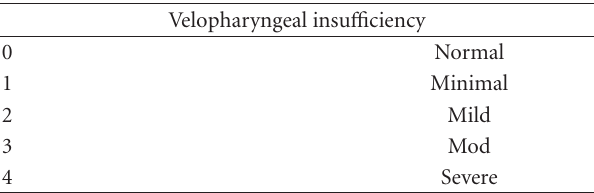
Table 4: Ranking of velopharyngeal insu ffi